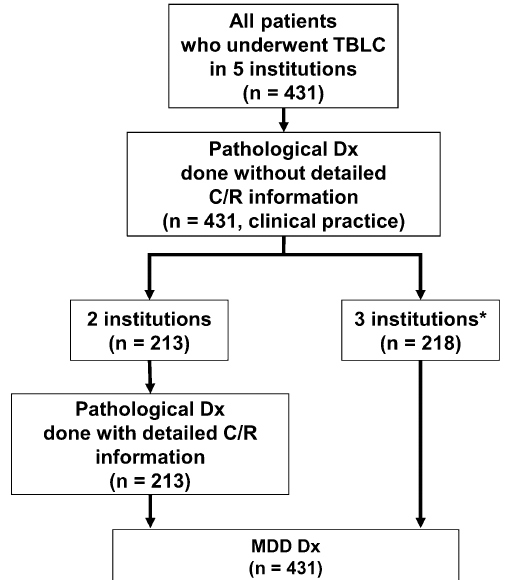
Figure 1. The flowchart on pathology and multidisciplinary discussion (MDD) diagnoses collected for this study. * At these three facilities, pathological diagnosis was performed with only the following information presented: age, sex, and location of the sampling